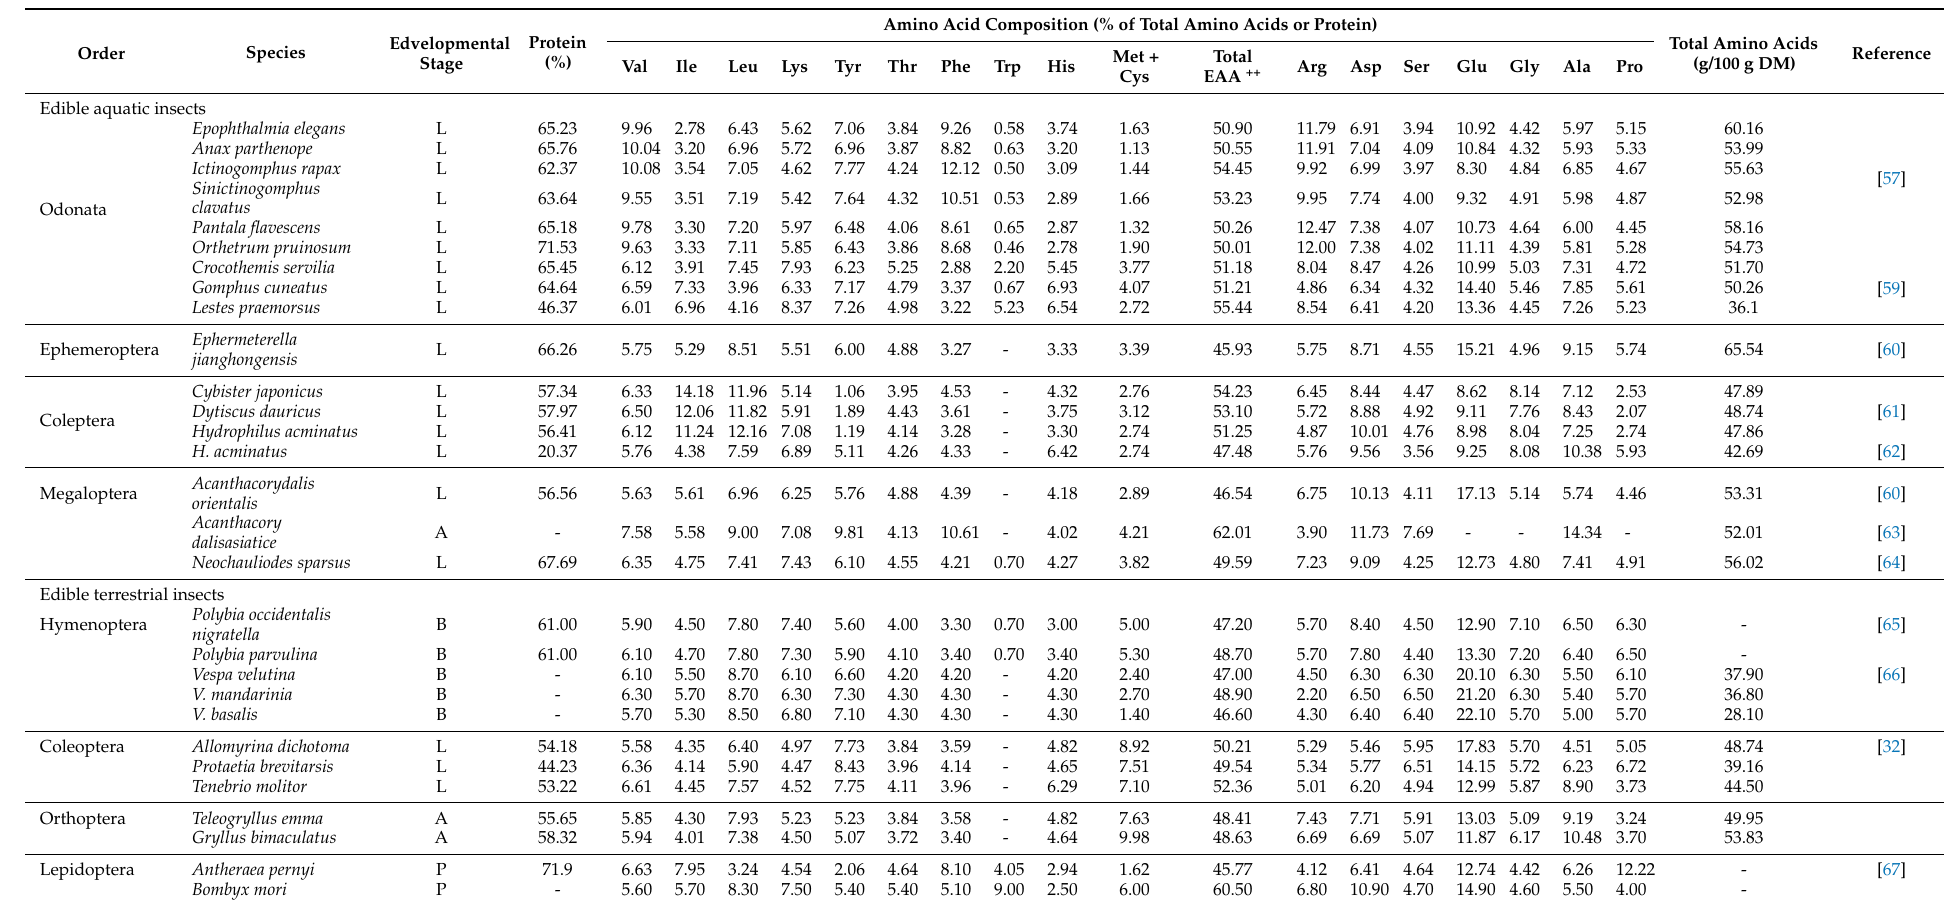
Table 2. Amino acid composition of edible aquatic insects and selected edible terrestrial